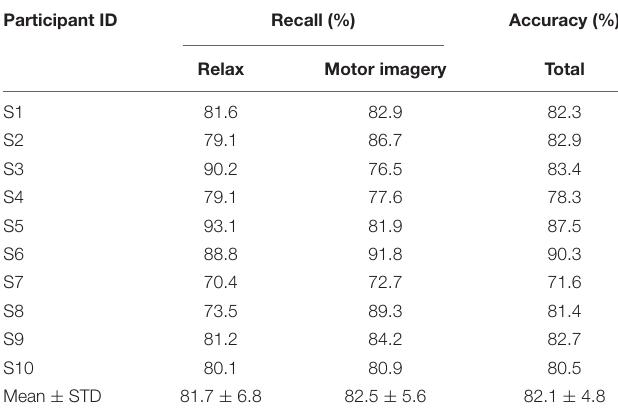
TABLE 1 | The fivefold cross-validation BMI classification performance for each subject. Participant ID Recall (%)